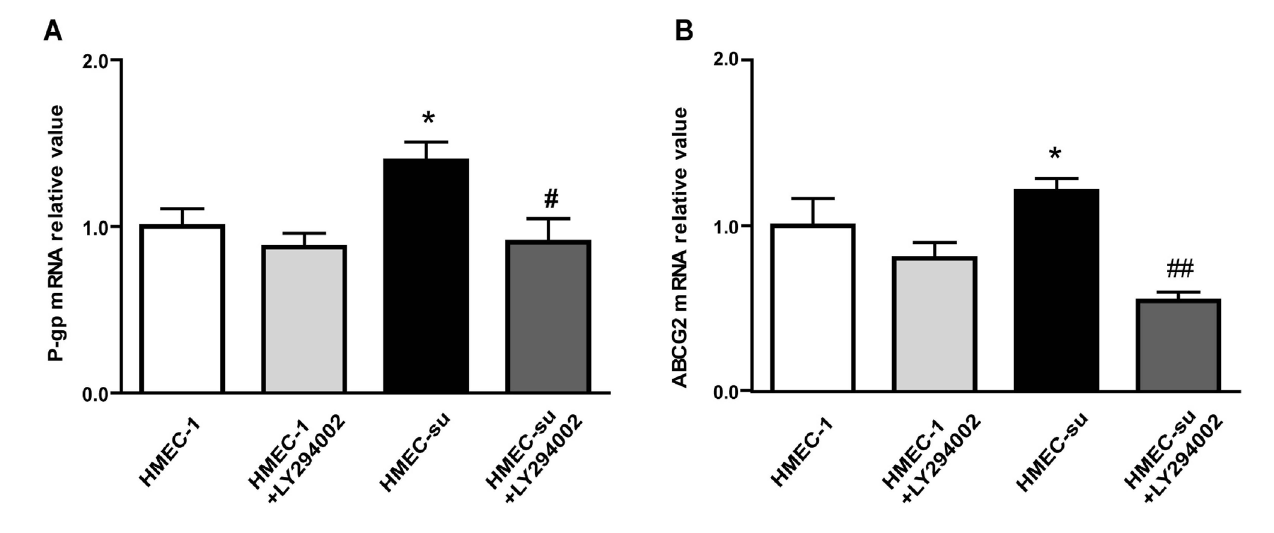
FIGURE 4 - LY294002 down-regulates gene level of (A) P-gp and (B) ABCG2 in resistant HMEC-su cells at 10 µM after 24 h treatments. Data reflect means ± SE values of three independent experiments with one-way ANOVA with Post-hoc correction. **P < 0.01 and *P < 0.05 vs. HMEC-1 cells, ## P < 0.01 and # P < 0.05 vs. HMEC-su